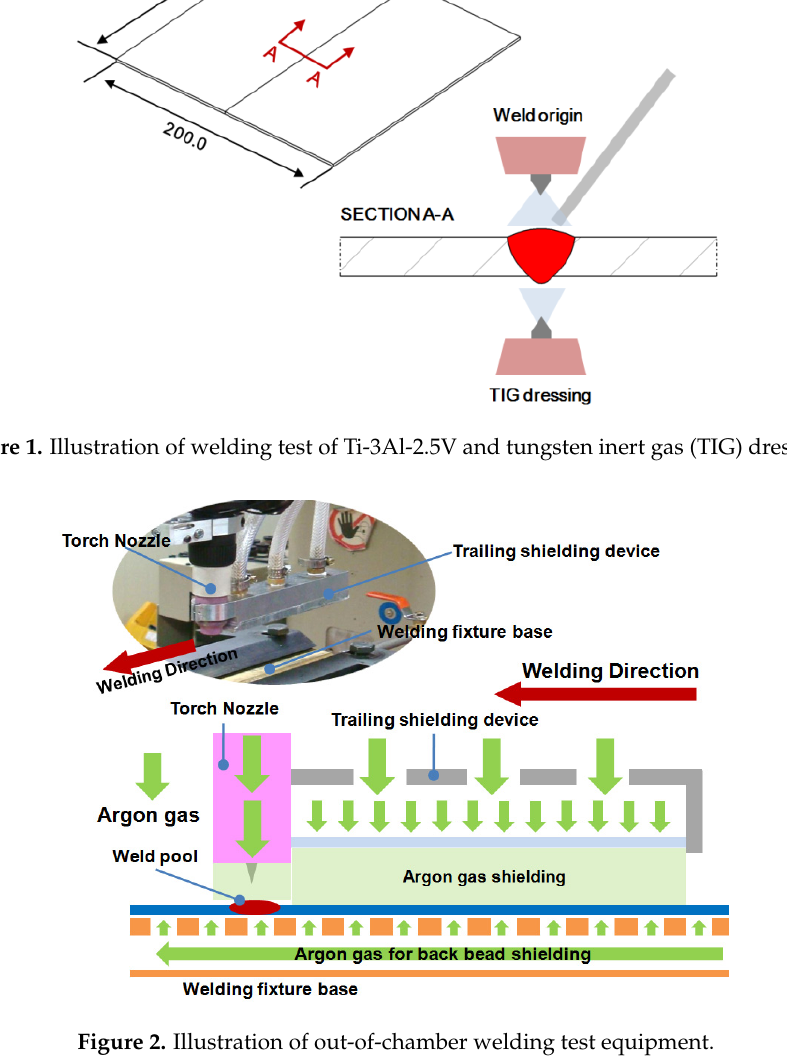
Figure 2. Illustration of out-of-chamber welding test equipment. Table 1. Chemical compositions of base metal and filler metal (wt %).